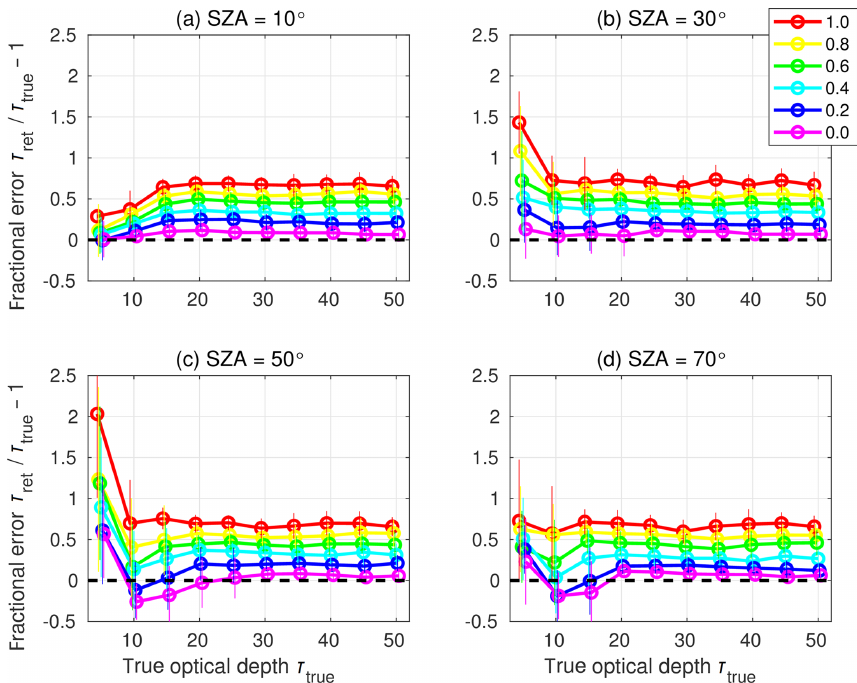
Figure 4. Retrieved optical depth as a fraction of true optical depth ( (cid:49)τ ret /τ true ) as a function of the true optical depth in the idealised cloud columns. Retrievals are made from DISORT radiance calculations with a liquid effective radius of 8µm, an ice effective diameter of 25µm and four values of solar zenith angle (see panel headers). Lines and markers as described in Fig. 3.